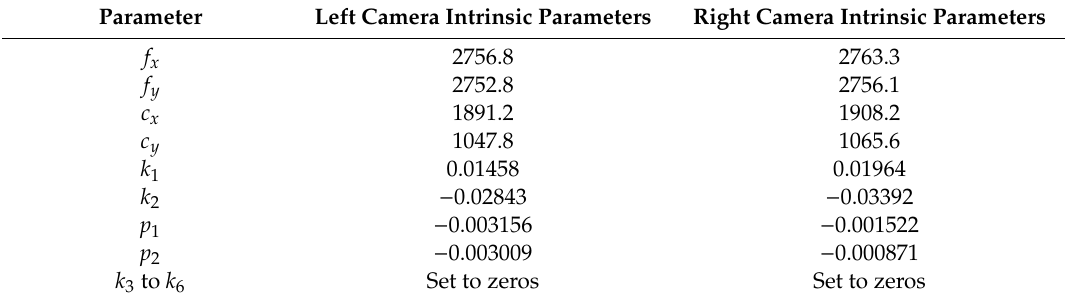
Table 1. Intrinsic parameters of cameras in the 3-story RC building experiment.